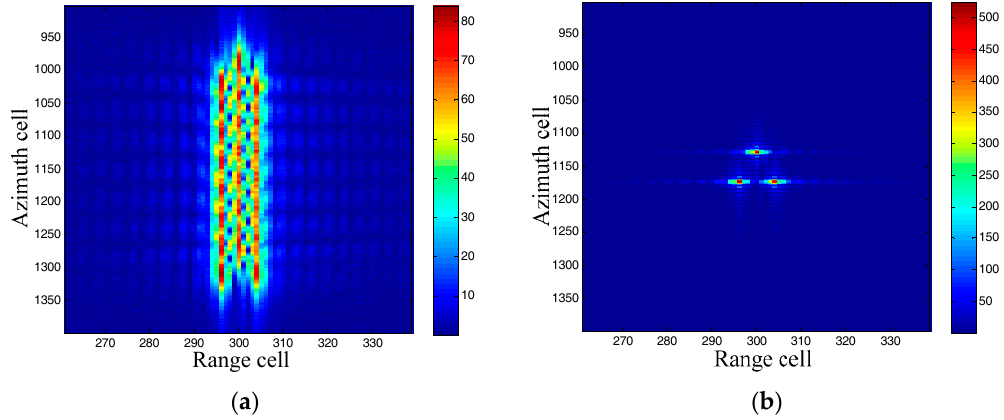
Figure 5. Moving targets imaging results. ( a ) by RDA with Doppler rate of stationary parameters, and ( b ) re-imaging results by the estimated Doppler rate.